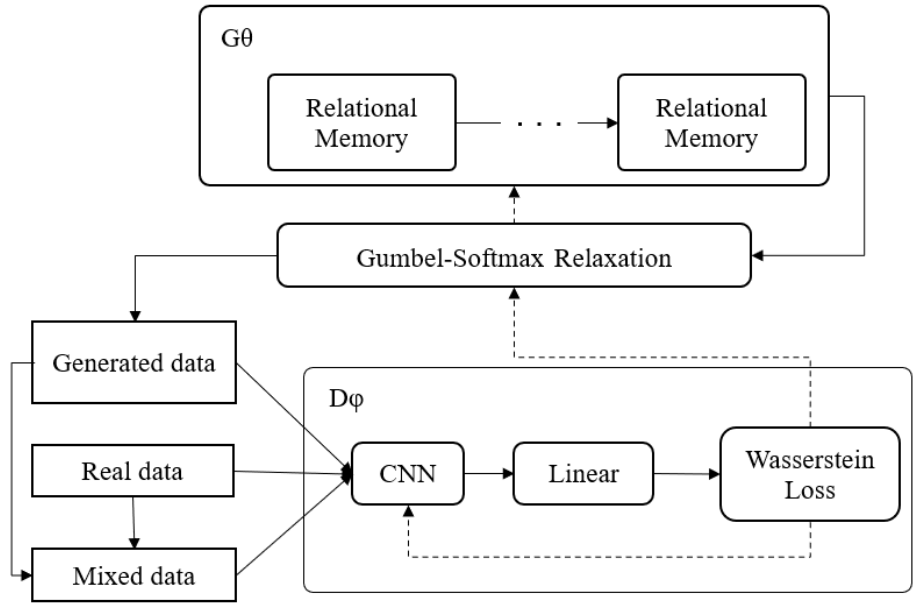
Figure 1. The overall framework of